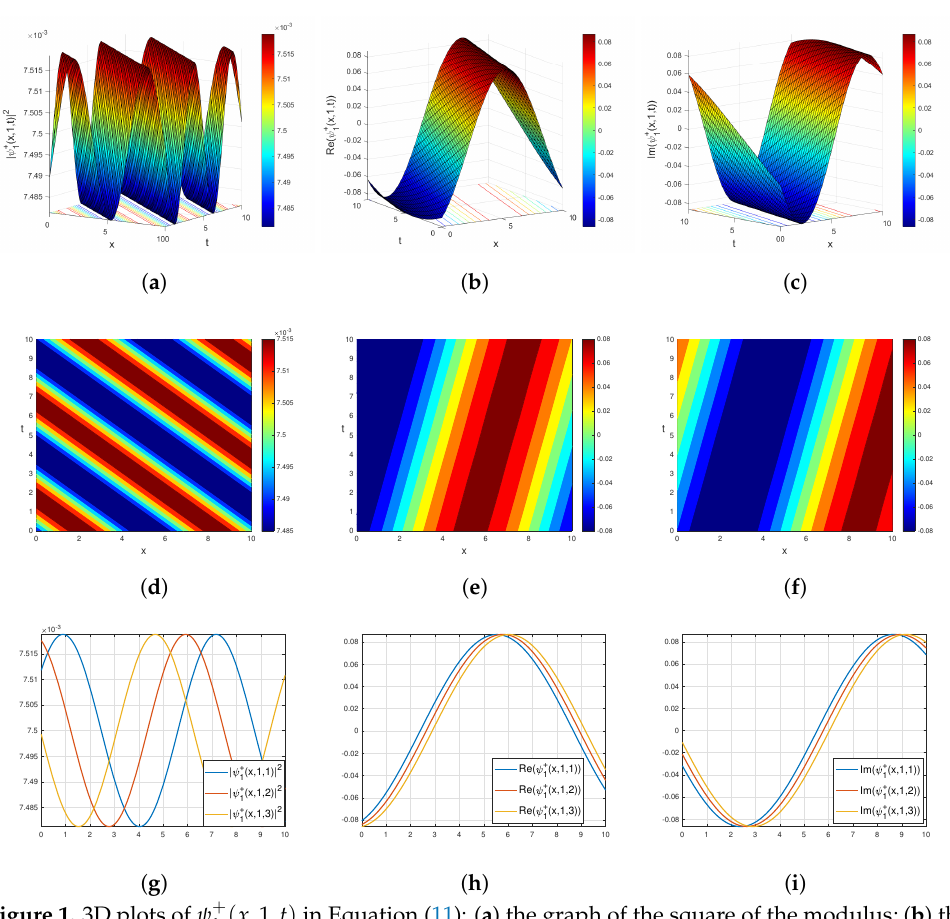
( x ,1, t ) in 1 ( x ,1, t ) for 1